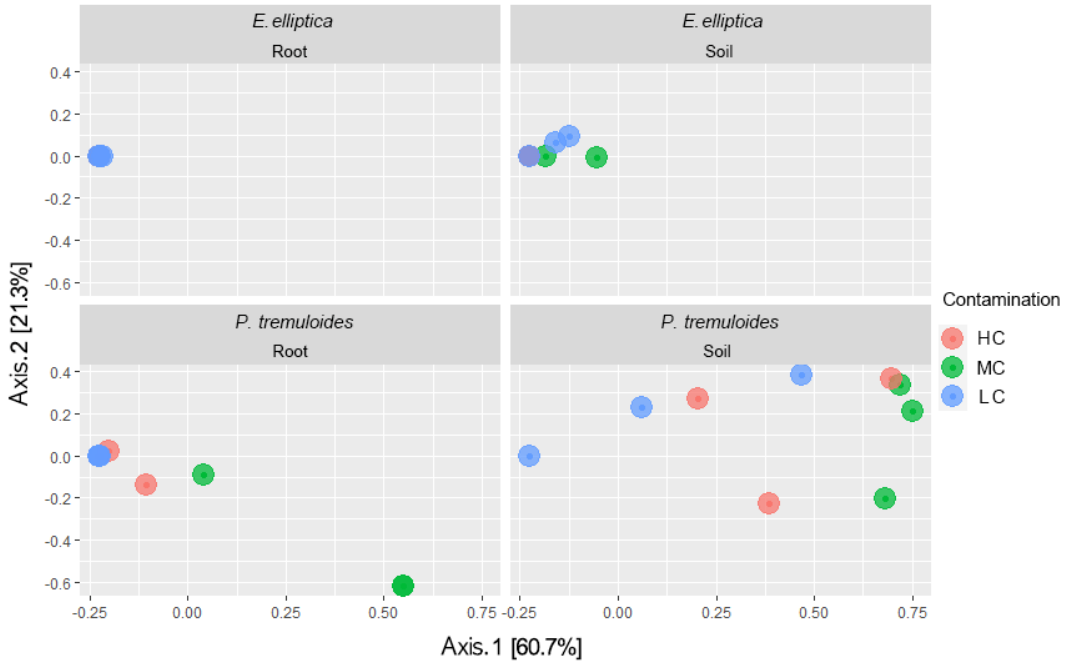
Figure 3. Principal coordinate analysis (PCoA) performed on AMF communities from the rhizosphere soil and roots of P. tremuloides and E. elliptica from decantation basins with lowest (LC, blue), intermediate (MC, green) and highest (HC, red) petroleum hydrocarbon contamination, based on Bray–Curtis dissimilarity. Axis 1 explains 60.7% of the variation in the community composition, while axis 2 explains 21.3% of the variation. In the samples of E. elliptica, overlapping of points existed.